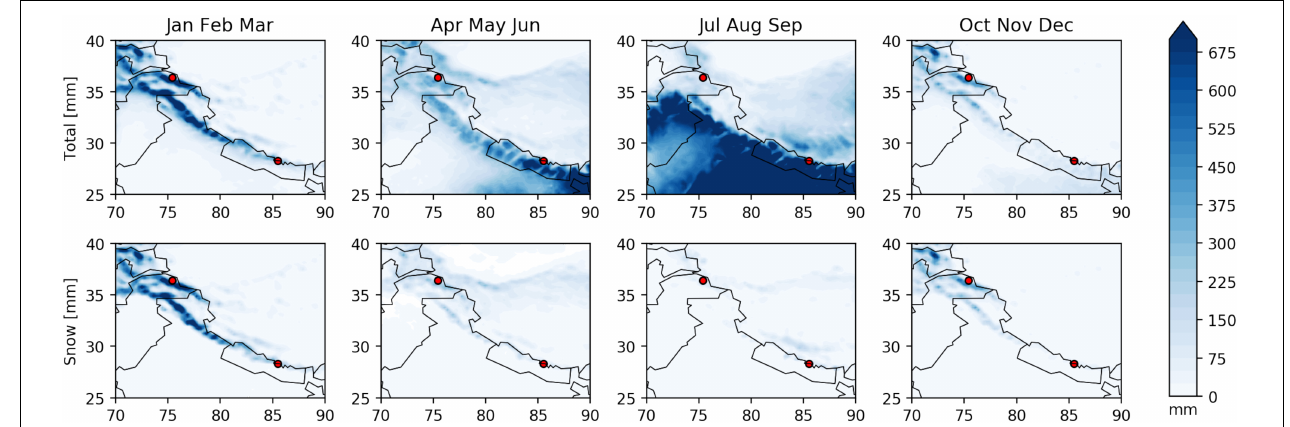
FIGURE 4 | Three-year-averaged seasonal total precipitation (upper panels) and solid precipitation (lower panels) for a subset of the 25-km resolution domain. Black contours indicate country outlines and the red markers the Shimshal (left) and Langtang (right) catchment.